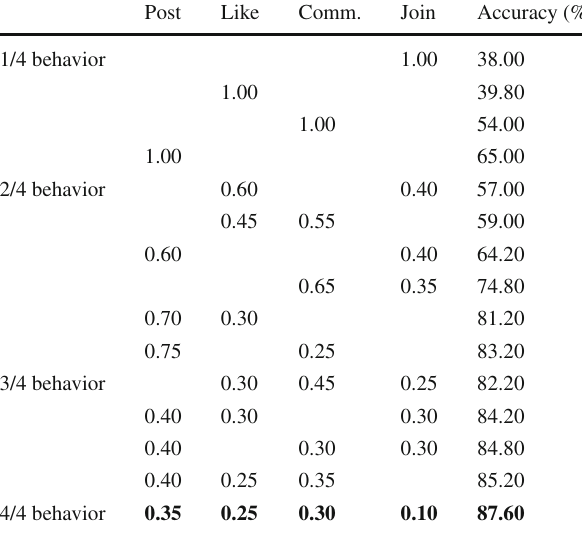
Table 5 Best weight of behavior for the sample